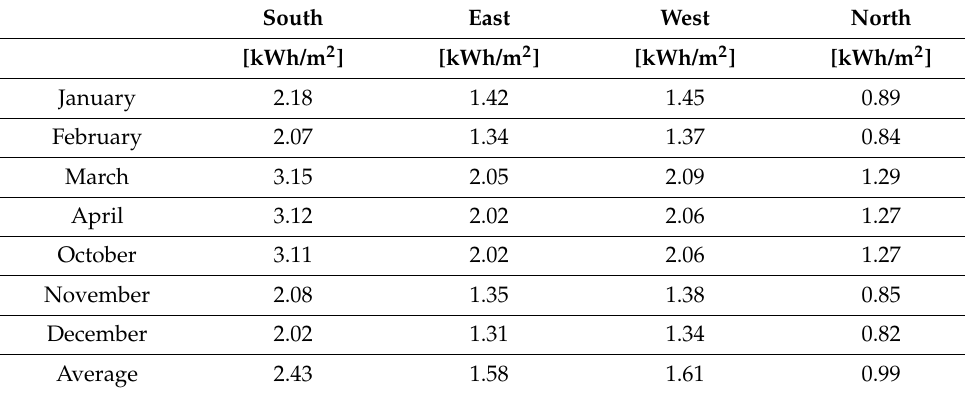
Table 3. Average daily monthly solar irradiation on a vertical plane for orientation for the winter period.